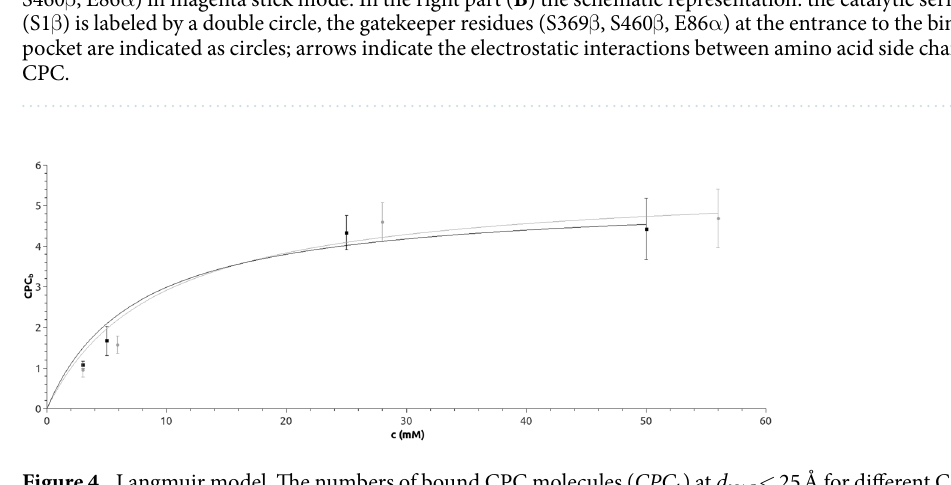
Figure 4. Langmuir model. The numbers of bound CPC molecules ( CPC b ) at d NAC < 25 Å for different CPC concentrations c were fitted to a Langmuir model (WT: black line, M6: grey